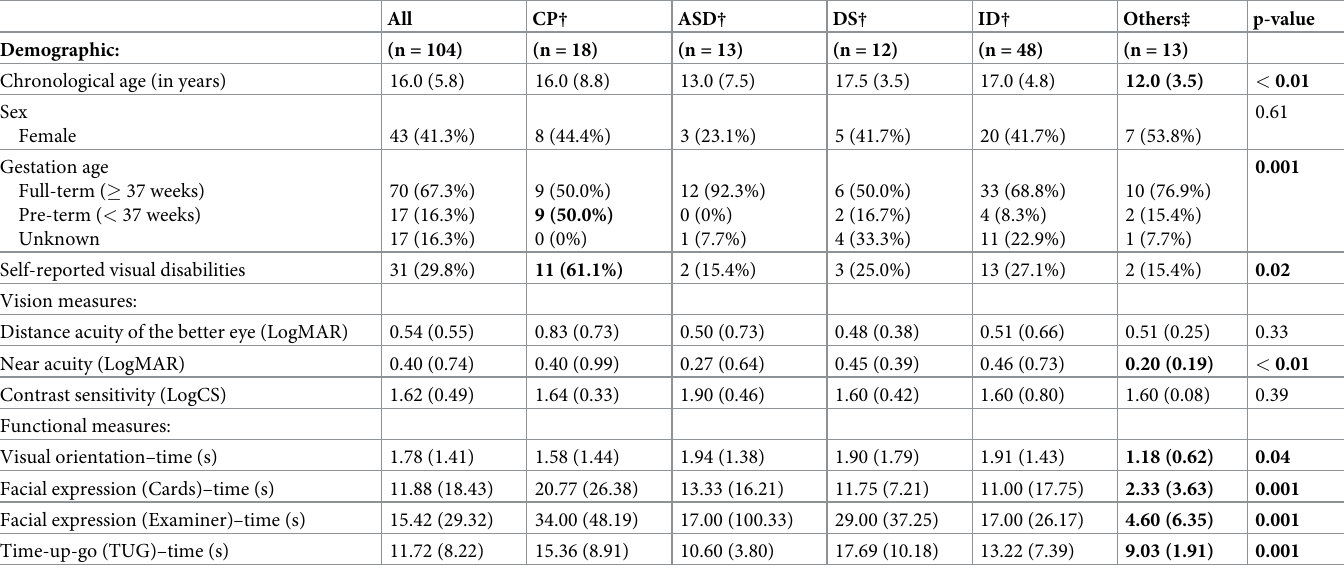
Table 1. Comparison of demographic, visual and functional performance among subtypes of SEN [median (IQR) or percentage].